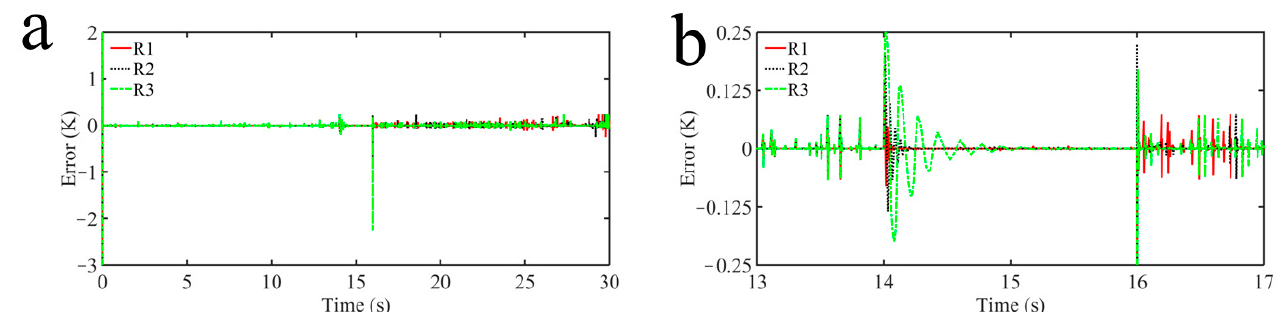
Figure 24. Simulation results with some external disturbances: ( a ) the tracking errors of Wall 0_0 mm for composite controller; ( b ) their partial enlarged figures in details.